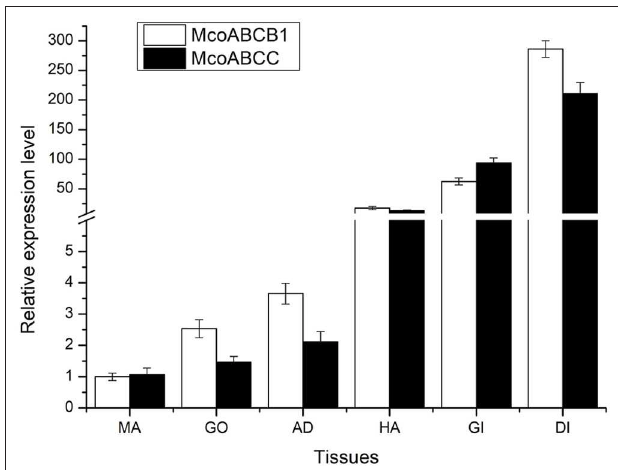
FIGURE 4 | Tissue distribution of Mco ABCB1 and Mco ABCC transcripts. The transcriptional expression levels of Mco ABCB1 and Mco AB CC are detected in various types, such as gills, GO, DI, AD, MA, and HA, by using qRT-PCR assay. Data are presented as mean ± S.D ( n = 8 per group), and β -actin was used as a reference